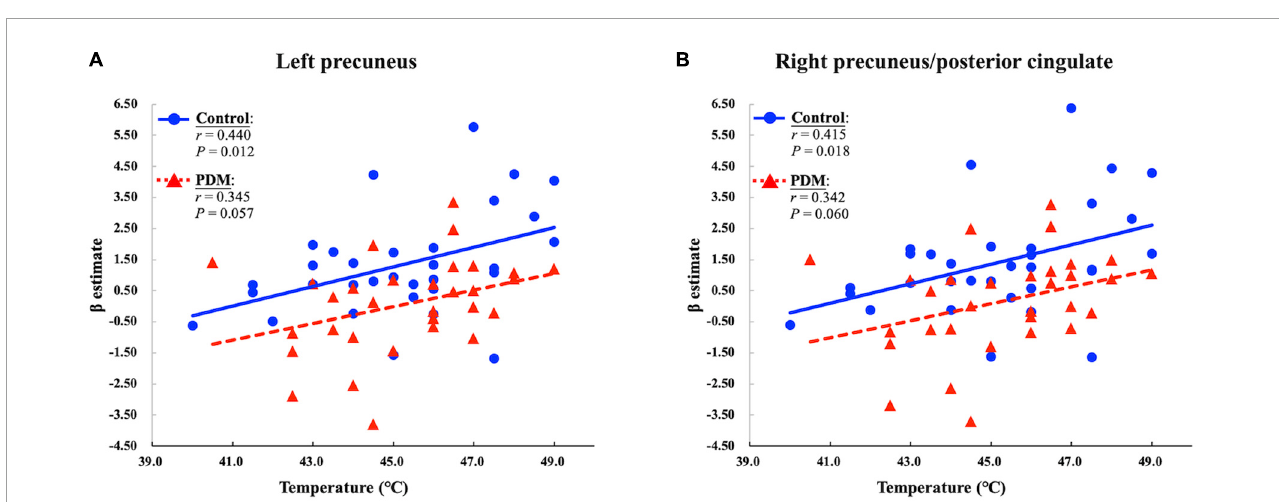
FIGURE2 The primary dysmenorrhea (PDM) group presented a reduced positive correlation between the individual-defined temperature of moderate heat pain and the responses evoked in the (A) left precuneus and (B) right precuneus/posterior cingulate during the painful menstrual phase. P and r values for the partial correlation analysis in the control and PDM groups are